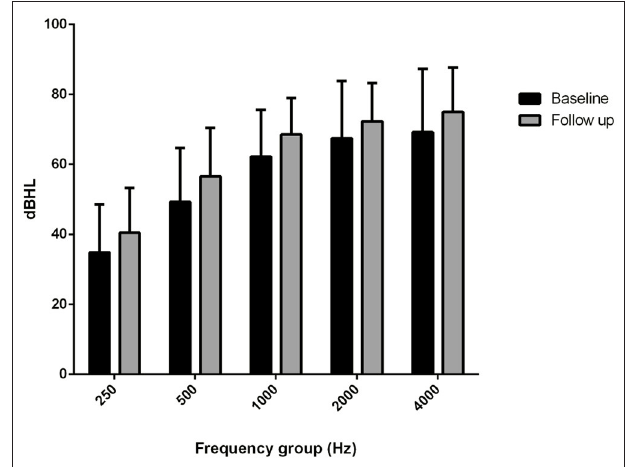
FIGURE 3 | Bone conduction threshold levels in the contralateral, non-implanted ear: baseline vs. follow-up (4–12 years).